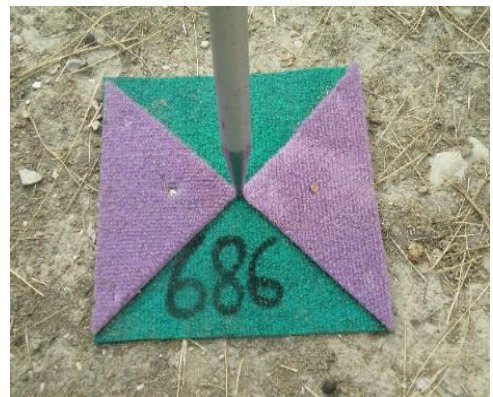
Figure 3. Artificial Ground Control Points